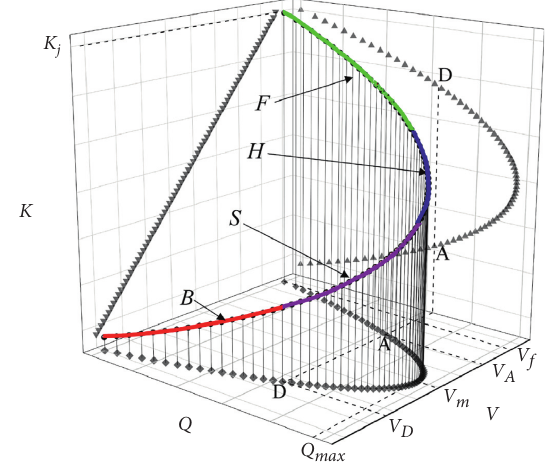
Figure 3: Traffic state curve.